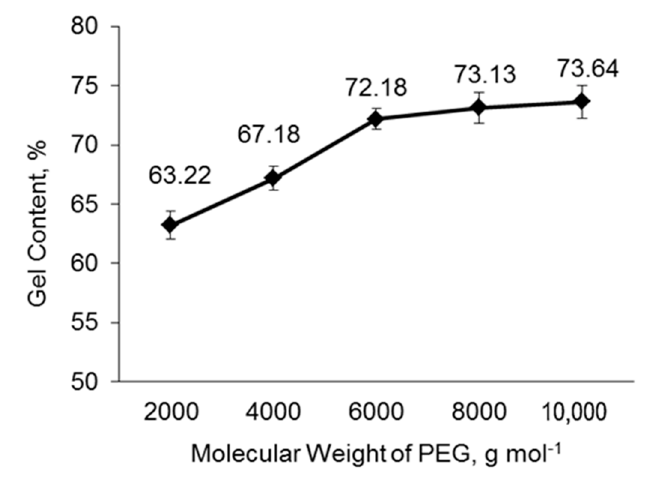
Figure 6. Gel content of PU matrices with different PEG molecular weights.